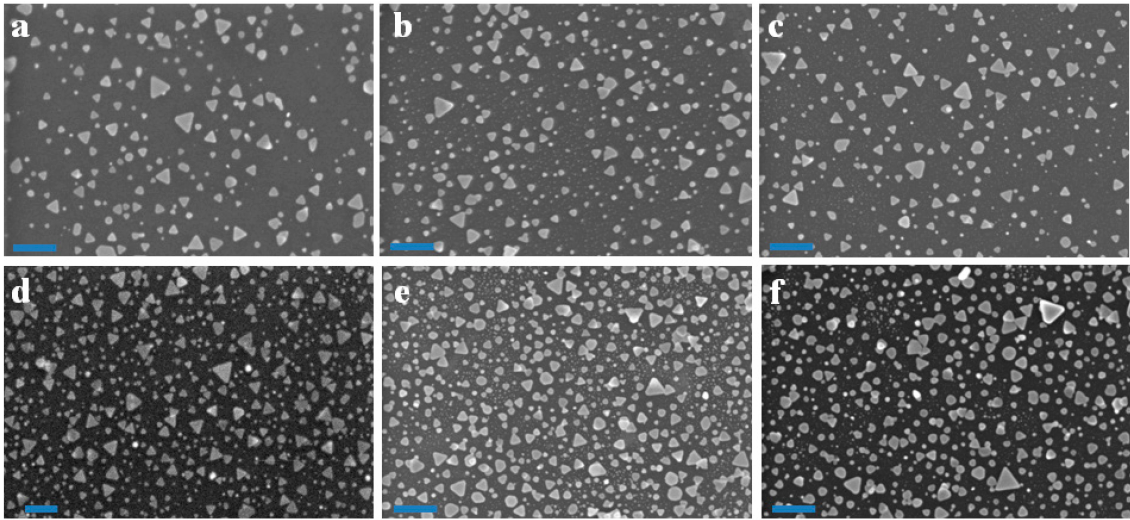
Figure 4. FESEM images of triangular silver nanoplate thin films formed after varying exposure times of ( a ) 30 min, ( b ) 1 h, ( c ) 2 h, ( d ) 8 h, ( e ) 14 h, and ( f ) 22 h. Scale bar is 100